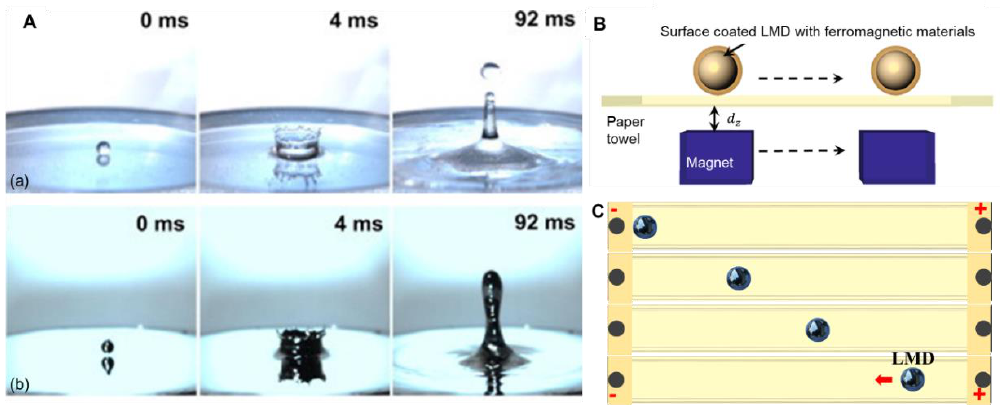
Figure 2. Typical properties of liquid metal. ( A ) Comparison of splashing process of water ( a ) and liquid metal ( b ), reproduced with permission from [74]; ( B ) Schematic of the magnet-controlled moving of an EGaIn droplet coated by ferromagnetic materials, reproduced with permission from [76]; ( C ) Sequential snapshots of a EGaIn droplet’s motion, reproduced with permission from [76];.